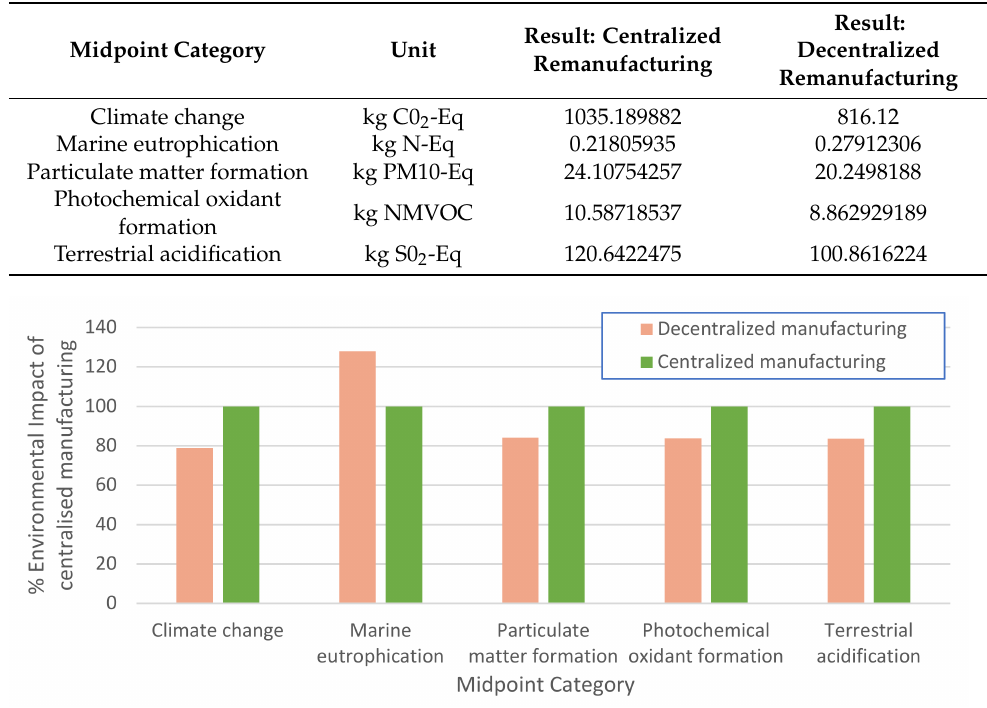
Table 6. LCA results of remanufacturing operation over one month.